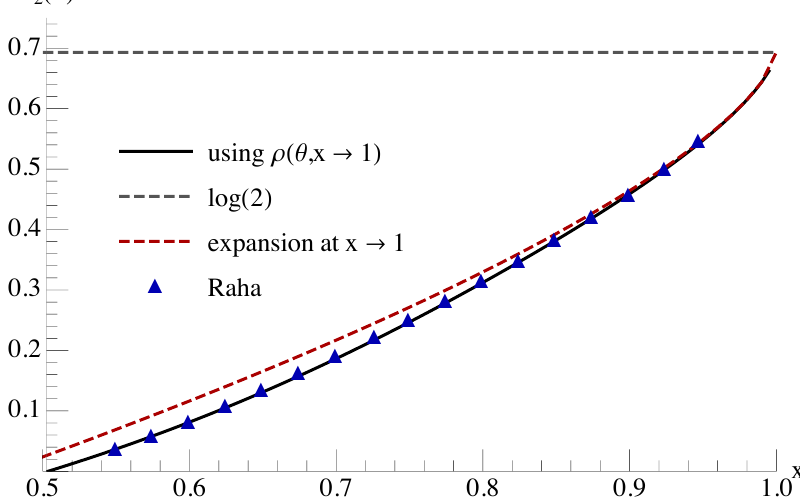
Figure 5 . Evaluation of the order parameter F 2 ( x ). The black curve is the result of the evaluation of (3.16) using the asymptotic quadratic density in (2.13). Blue triangles are exact numerical data points taken from [13]. Finally, the brown dashed curve is the analytical approximation in